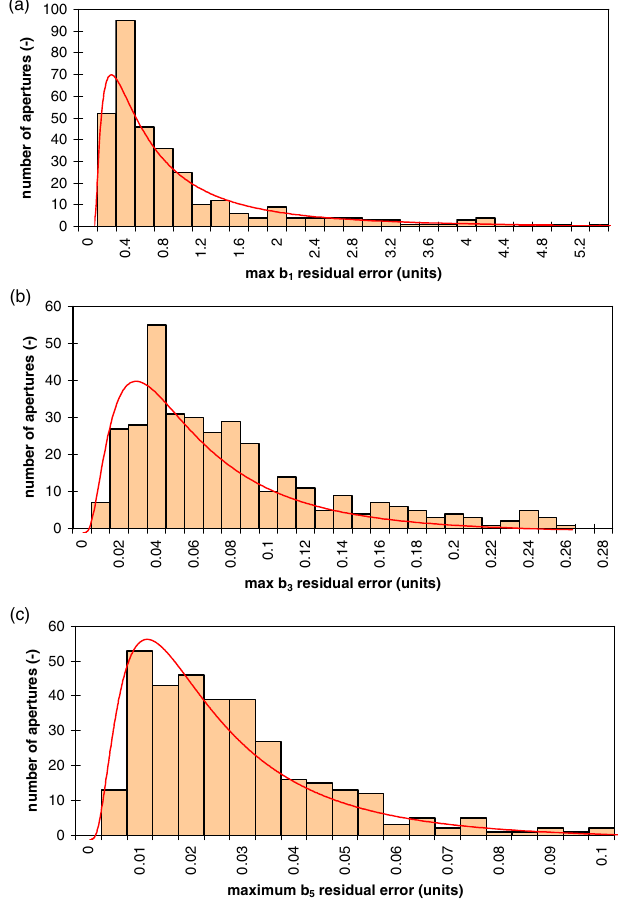
FIG. 5. (Color) (a), (b), (c) Histograms and log-normal distribu- tion of the maximum residual error for b tively, between the scaled harmonic decay and the average harmonic decay of the magnet set